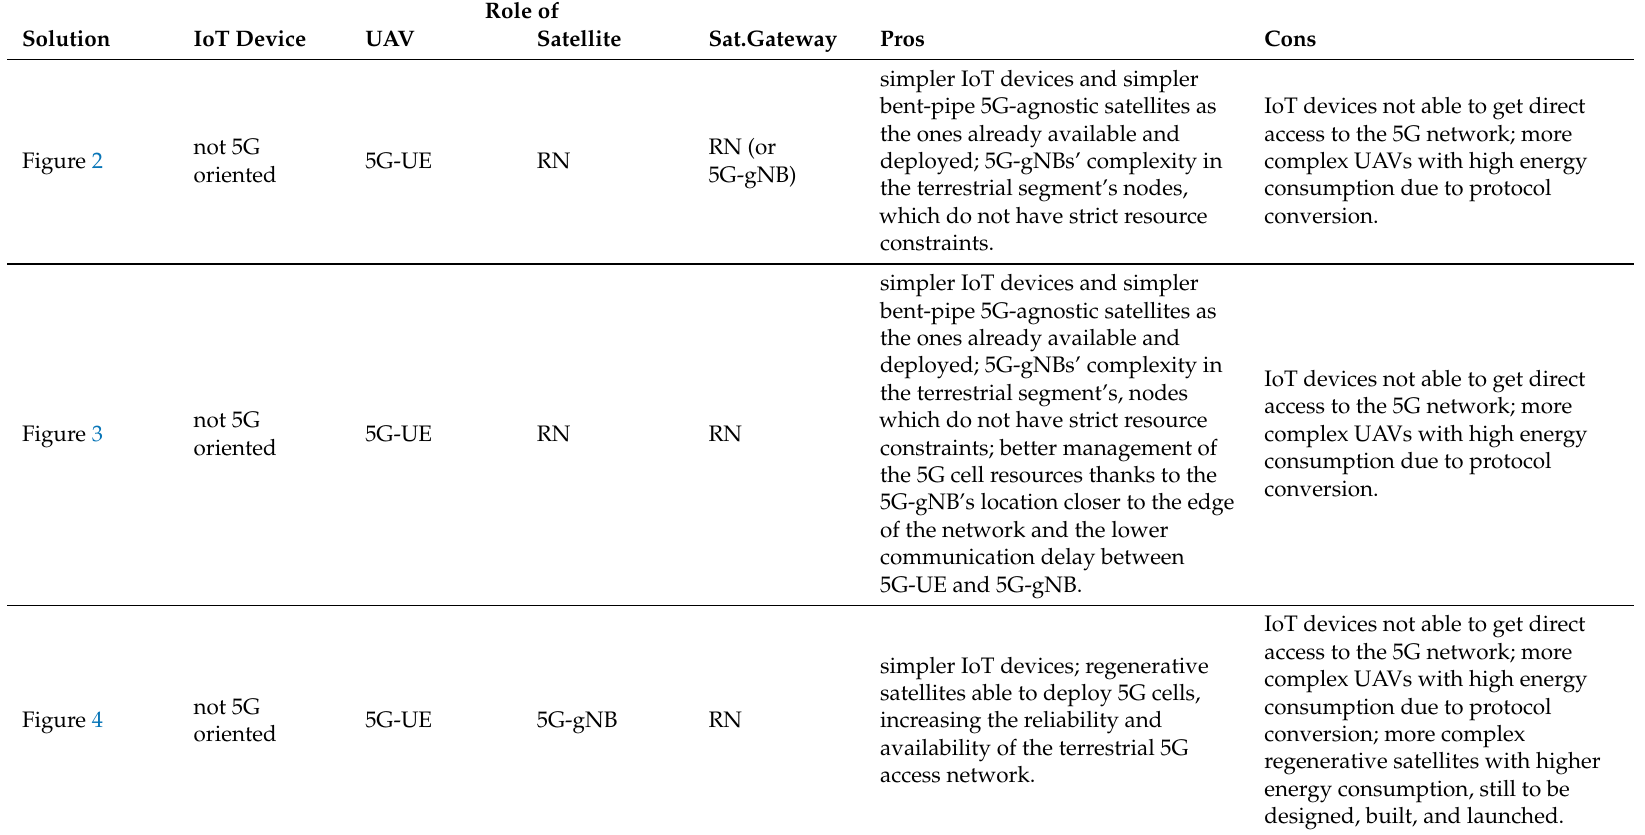
Table 3. Pros and cons of the identified integrated